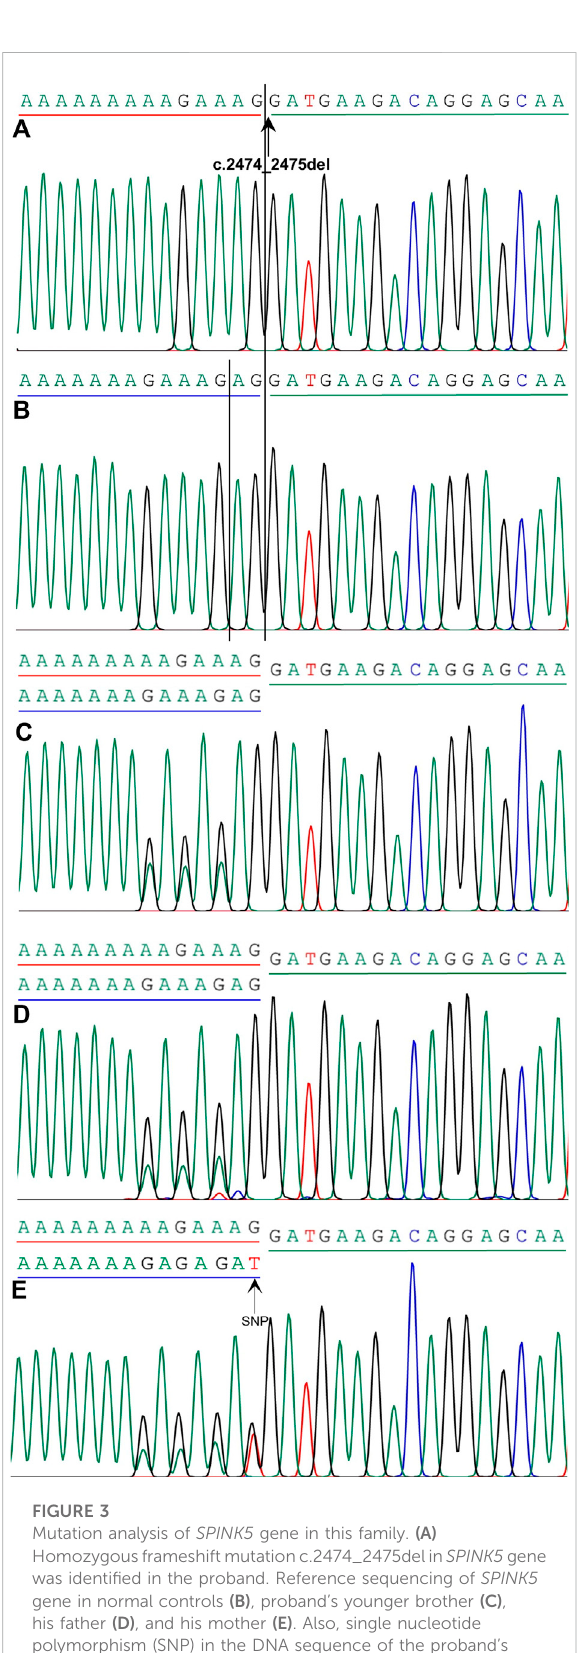
FIGURE 3 Mutation analysis of SPINK5 gene in this family. (A) Homozygousframeshiftmutationc.2474_2475delin SPINK5 gene was identi fi ed in the proband. Reference sequencing of SPINK5 gene in normal controls (B) , proband ’ s younger brother (C) , his father (D) , and his mother (E) . Also, single nucleotide polymorphism (SNP) in the DNA sequence of the proband ’ s mother was